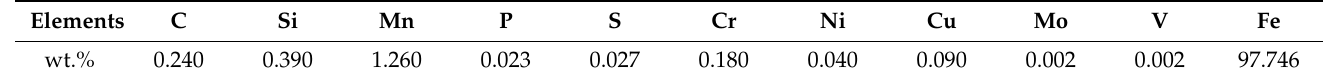
Table 1. Chemical composition of the steel rebar used in this study.